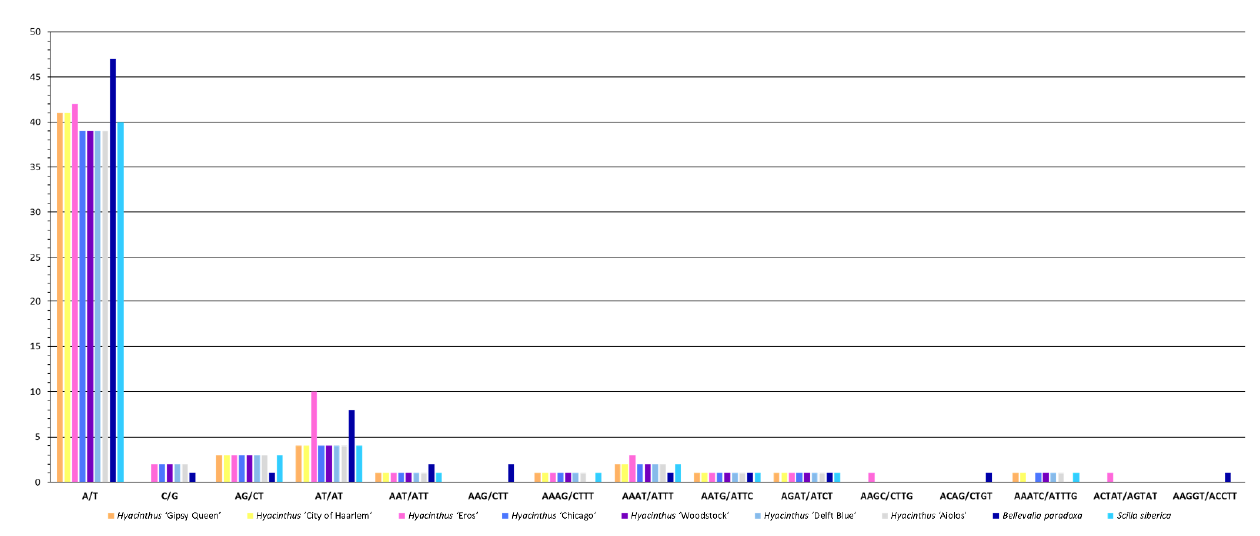
Figure 5. Abundance of SSRs classified by different sequence complementarity among the nine studied chloroplast genomes.